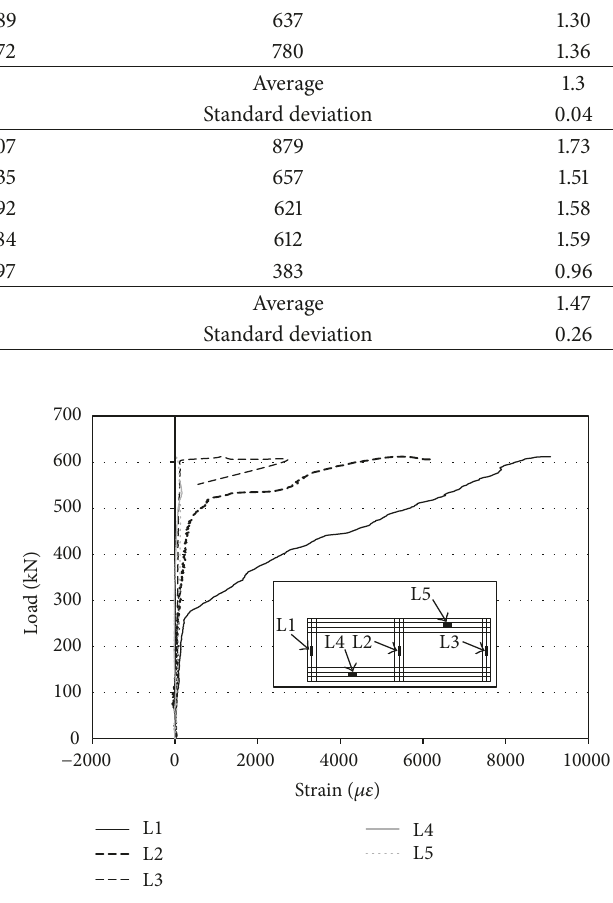
Figure 11: Load versus GFRP strain for the GC-184